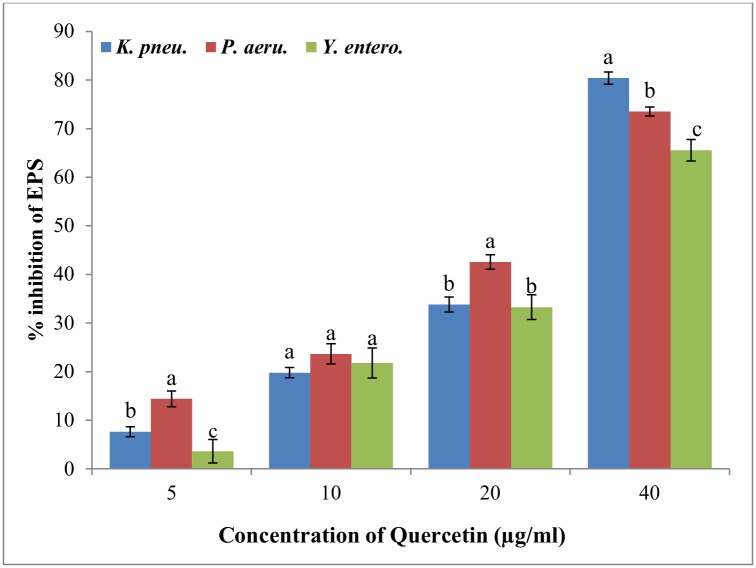
Quantitative analysis for inhibition of EPS production in test strains by quercetin at different concentration (0–40μg/ml).Data represented were mean of triplicate values with standard deviation. Same letters in the column are not significantly different (p< 0.05).